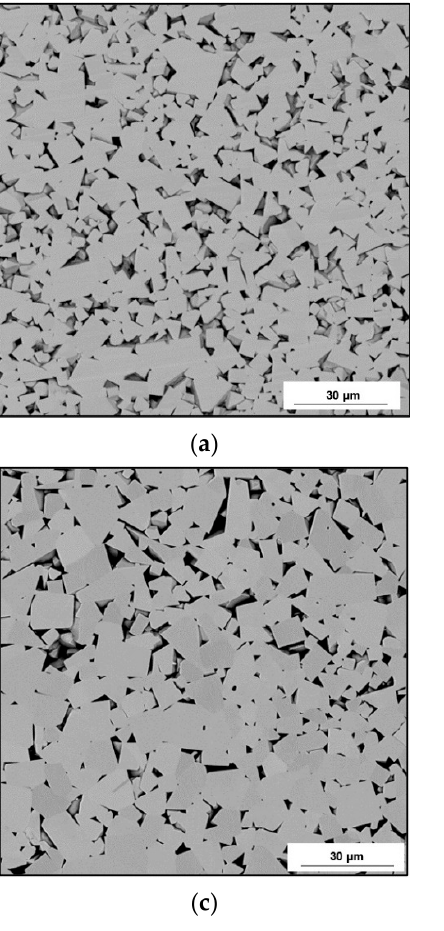
Figure 5. Microstructures of the examined tips made of sintered WC-Co: ( a ) Longwall 1 tip, ( b ) Road 1 tip, ( c ) Longwall 2 tip, ( d ) Road 2 tip. Scanning Electron Microscope (SEM), Back Scattered Electron (BSE).